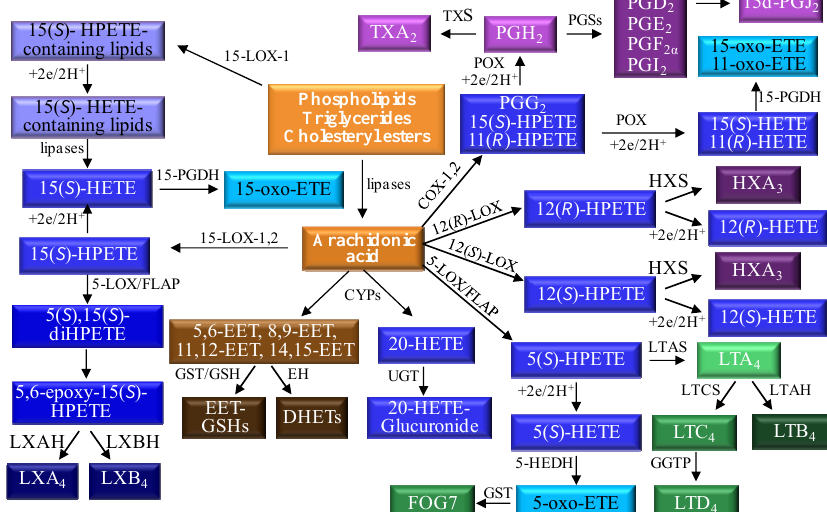
Figure 1. Pathways of arachidonic acid metabolism. Abbreviations: COX, cyclooxygenase; CYP, cytochrome P540; EET, epoxyeicosatrienoic acid; EH, epoxide hydrolase; FLAP, 5-lipoxygenase activating protein; GGT, γ -glutamyltranspeptidase; GSH, glutathione; GST, glutathione- S -transferase; H, hydrolase; HEDH, hydroxyeicosanoid dehydrogenase; HETE, hydroxyeicosatetraenoic acid; HPETE, hydroperoxyeicosatetraenoic acid; HX, hepoxillin; LOX, lipoxygenase; LT, leukotriene; LX, lipoxins; PG, prostaglandin; PGDH, prostaglandin dehydrogenase; POX, peroxidase; S, synthase; TX thromboxane; UGT,